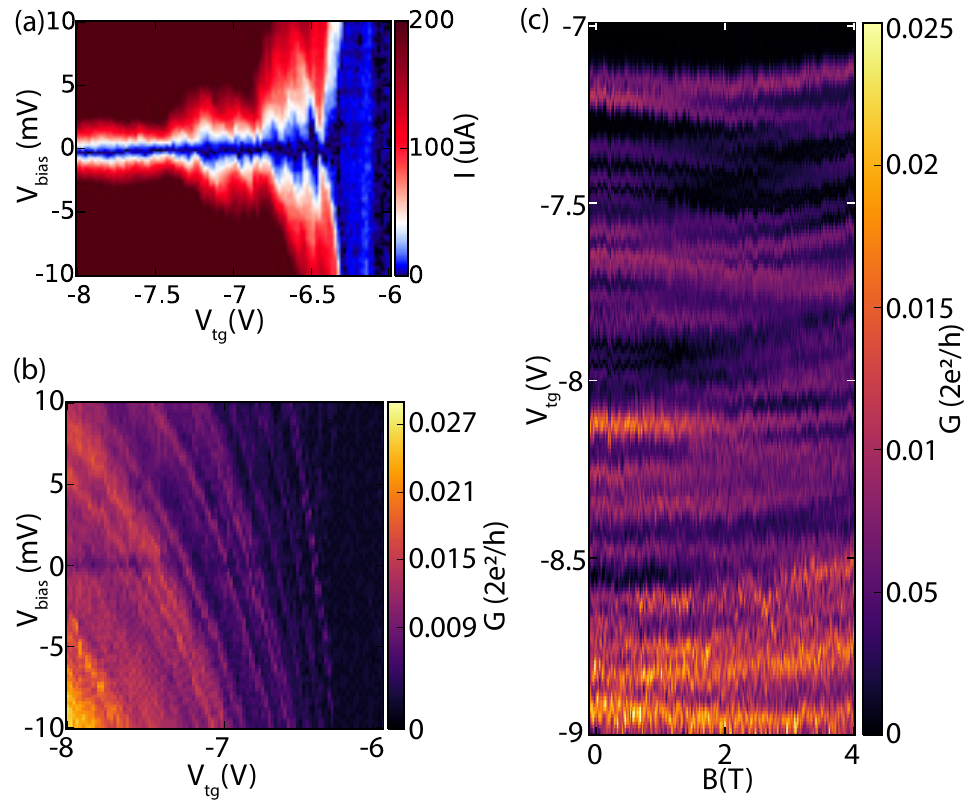
Figure S7: Hole states in device 3. (a) and (b) absolute value of current and differ- ential conductance of the hole quantum dot, both panels are derived from the same dataset. B = 0. (c) Magnetic field evolution at V is